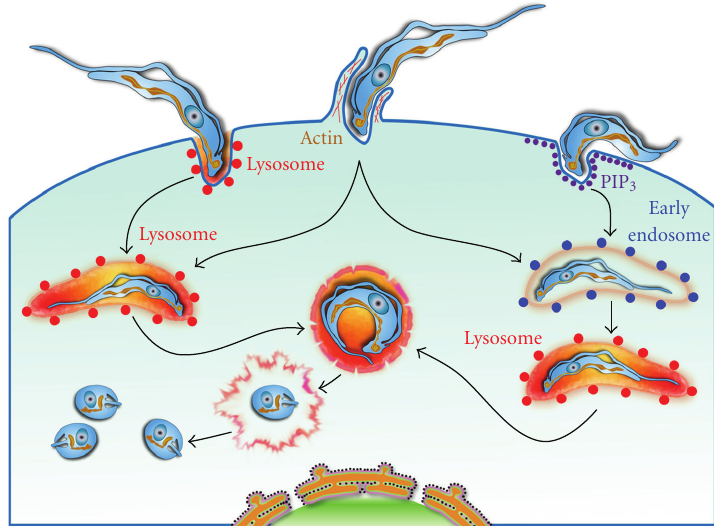
Figure 10: Model of T. cruzi invasion. The model indicates three distinct mechanisms of T. cruzi entry into host cell. (a) the lysosome- dependent pathway is initiated by targeted Ca 2+ -regulated exocytosis of lysosomes in the plasma membrane; (b) in the actin dependent pathway trypomastigotes penetrate into a host cell through a plasma membrane expansion that culminates in assembly of a parasitophorous vacuole. Either learly endosomes or lysosomes can fuse with the parasitophorous vacuole; (c) in the lysosome-independent pathway, parasites enter cells through plasma membrane invaginations that accumulate PIP 3 (product of class I PI3K activation). Subsequently, internalized parasites are contained in vacuoles formed from the plasma membrane and it maturates with the acquisition of early endosome markers (rab5 and EEA1) and subsequently with the acquisition of lysosome markers. Later on, the the trypomastigote form gradually transform into a amastigote form with simultaneous lysis of the parasitophorous vacuole membrane. Then, amastigotes in direct contact with the cytoplasm start to